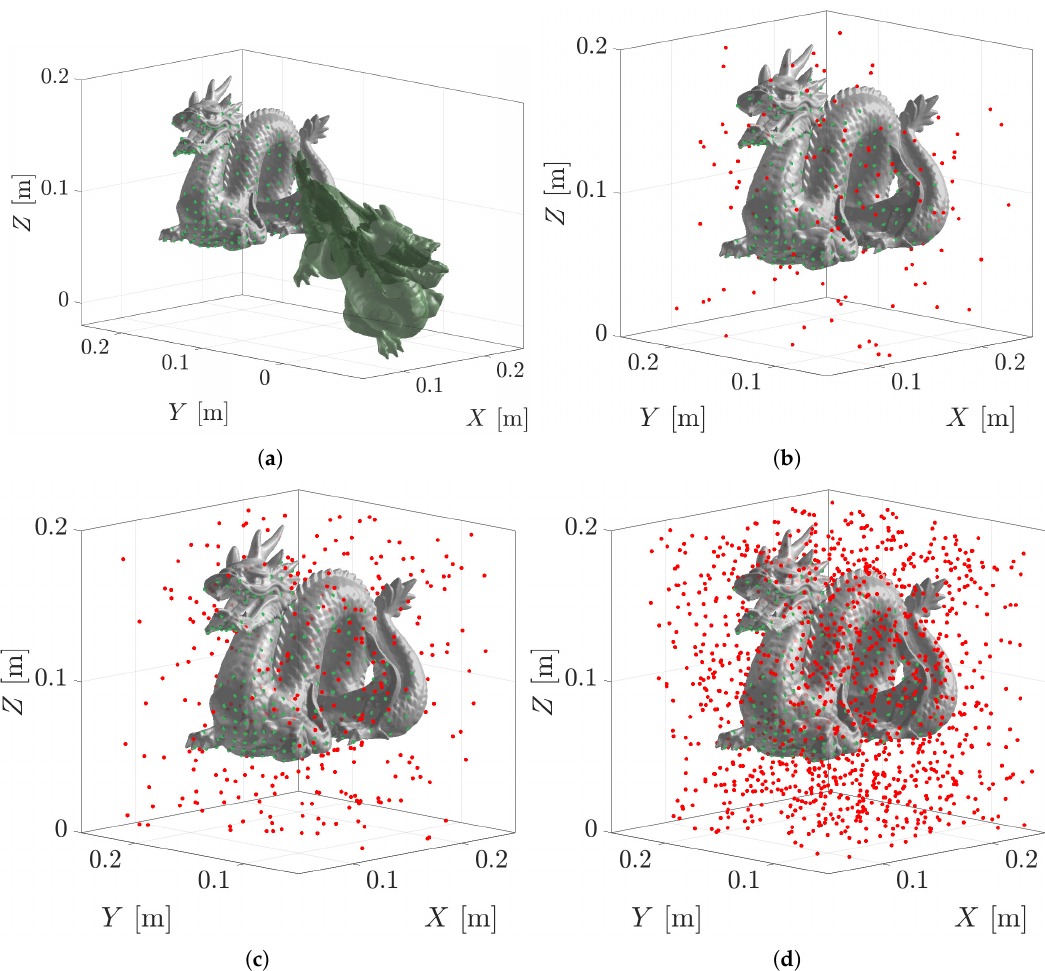
Figure 10. Real-world scenarios have unwanted measurements in the scene. The original point cloud is green, and the clutter measurements are red. The true pose of the dragon is T ★ S→M [